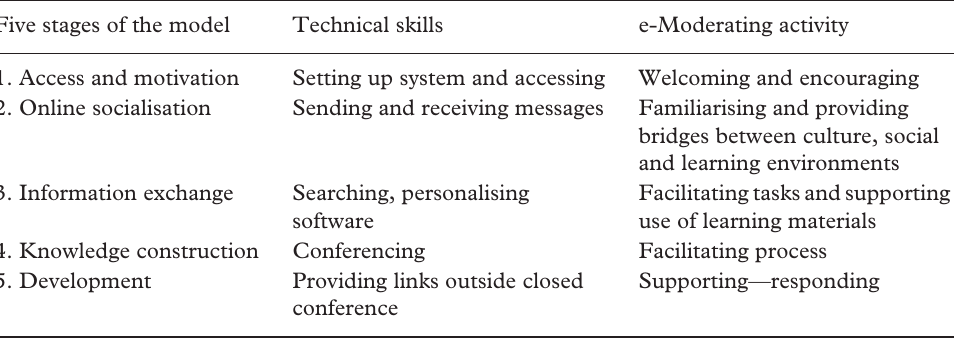
Table 1. An interpretation of the five-stage model (Salmon, 2003, p.